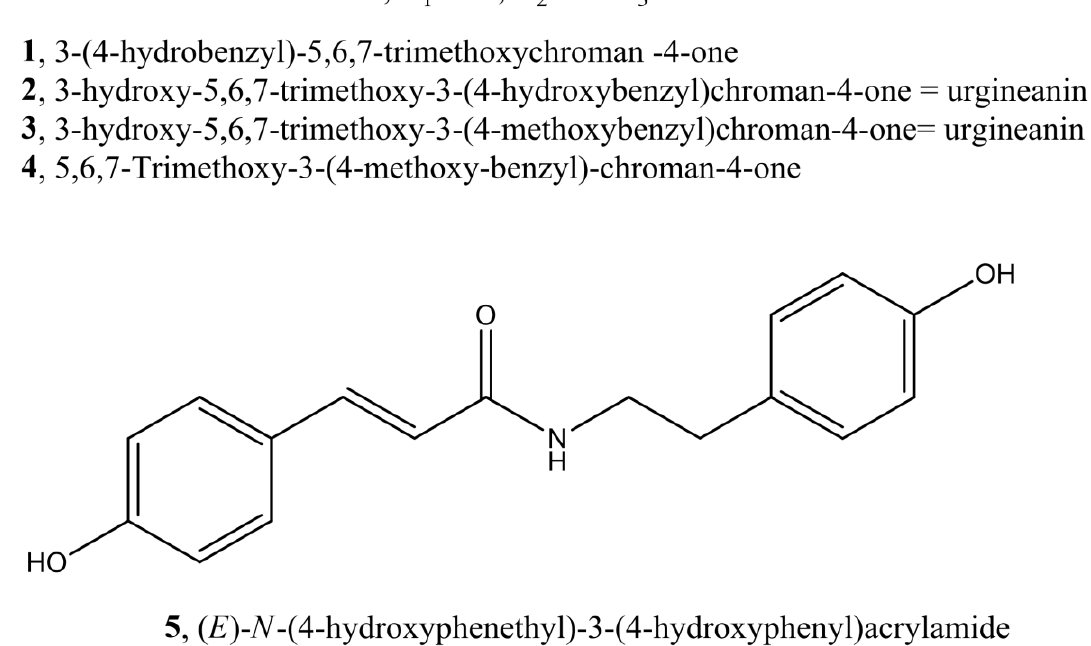
Figure 1. Structure of homoisoflavanoids ( 1 )–( 4 ) and alkylamide ( 5 ) isolated from C. biflorum bulbs. The identification of 1 was performed comparing its 1 H NMR spectrum with that reported in the literature when it was isolated for the first time from Scilla nervosa , subsp. rigidifolia collected in Botswana where it is used in Zulu folk medicine to treat rheumatic fever and as a purge for children [30]. ESI MS spectrum showed the potassium [2M + K] + and sodium [2M + Na] + dimeric, the potassium [M + K] + and sodium [M + Na] + and the protonated [M + H] + adduct ions at m / z : 727, 711, 383, 367 and 345. The structure of the homoisoflavanoid ( 1 ) was confirmed by X-ray analysis of a single crystal obtained by slow evaporation of a CHCl 3 -isoPrOH 9:1 v / v solution. Compound